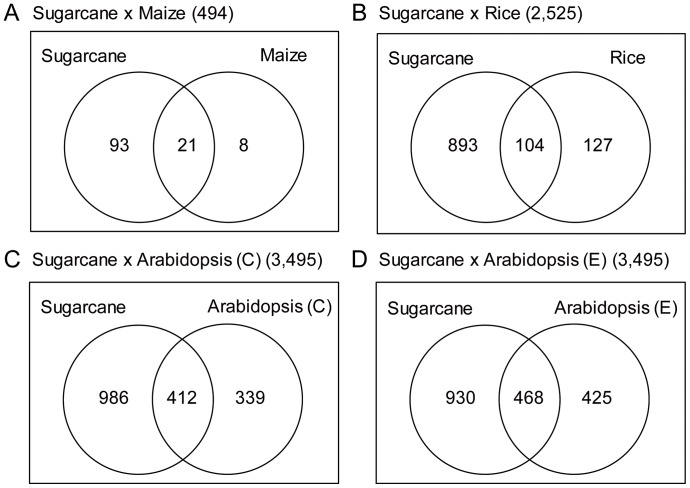
The sugarcane dataset has a higher proportion of circadian ortholog clusters in pairwise comparisons with other dataset.A list of common ortholog clusters was made for each pairwise comparison between the sugarcane dataset and (A) the maize dataset, (B) the rice dataset, (C) the Arabidopsis (Covington) dataset and (D) the Arabidopsis (Edwards) dataset. A Venn diagram was made for each comparison to show overlap between circadian ortholog clusters of each dataset used in the comparison.